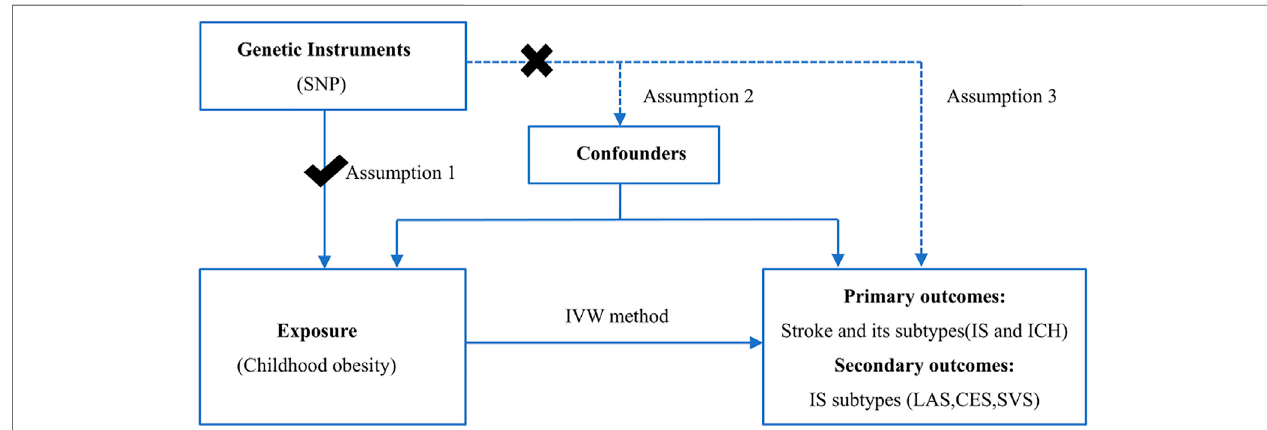
FIGURE1| AssumptionanddesignfortheMendelianrandomisationstudy.ThreeassumptionsinthisMRstudy:(Krishnamurthietal.,2020)Instrumentalvariables are correlated with exposure; (GBD 2016 Stroke Collaborators, 2019) instrumental variables are not associated with confounding factors; and (Feigin et al., 2016) the instrumental variable is not related to outcome and is only associated with outcome through exposure. IVW, inverse-variance-weighted; SNP, single nucleotide polymorphism; IS, ischemic stroke; LAS, large vessel ischemic stroke; CES, cardioembolic ischemic stroke; SVS, small vessel ischemic stroke; ICH, intracerebral